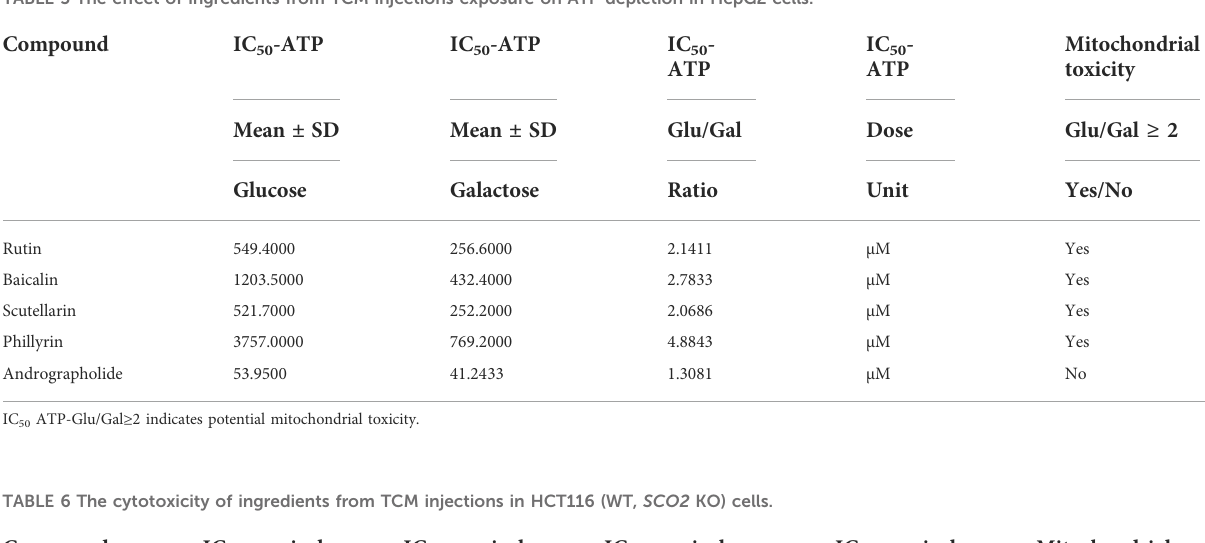
TABLE 6 The cytotoxicity of ingredients from TCM injections in HCT116 (WT, SCO2 KO) cells. Compound